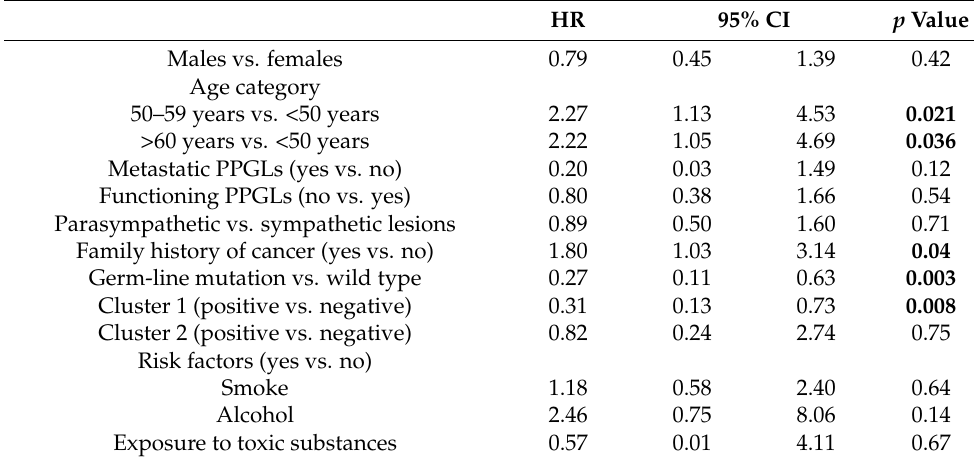
Table 4. Univariable analysis for incident second malignant tumor.